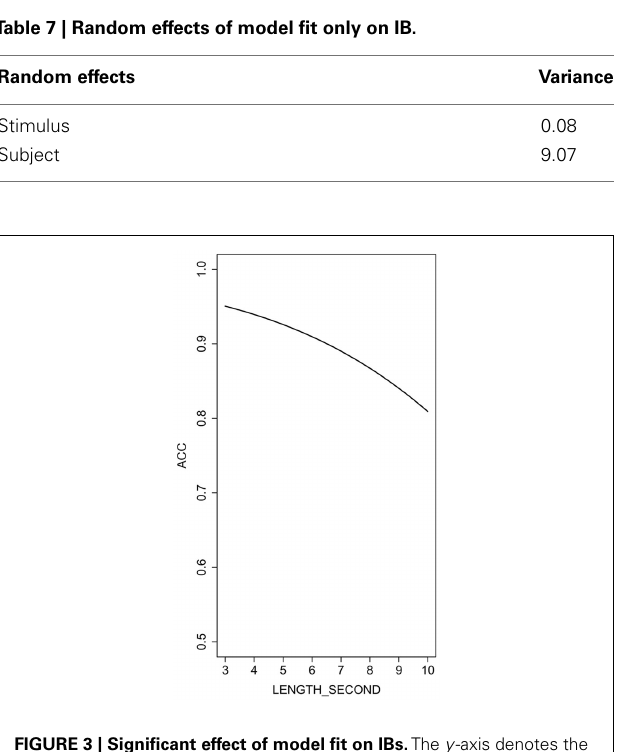
FIGURE 3 | Significant effect of model fit on IBs. The y -axis denotes the predicted reading accuracy (ACC), expressed as proportion of items correctly